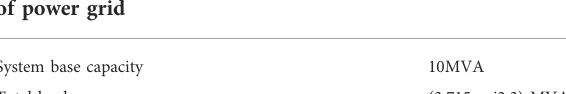
TABLE 2 Main parameters of power